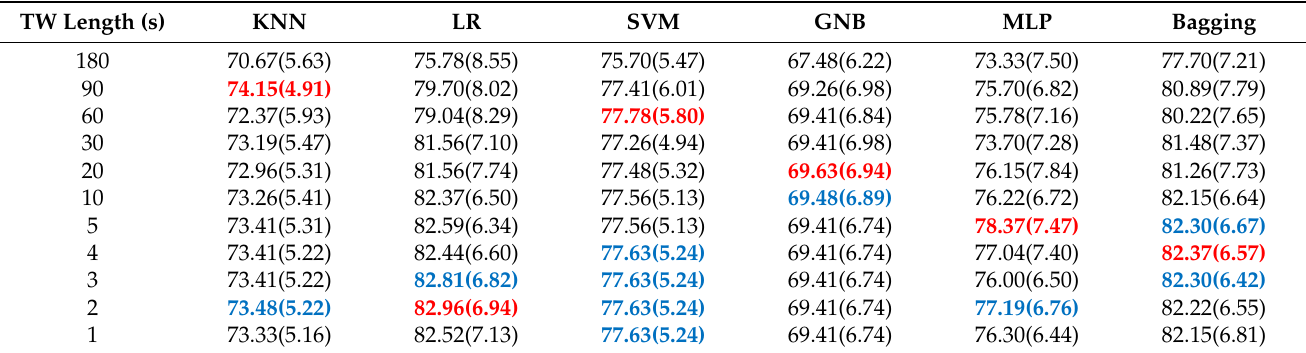
Table 8. The recognition results (mean accuracy and standard deviation) of DE features extracted from separate frequency bands when using different classifiers under different TW lengths with ELBN. The highest and second-highest accuracies of each classifier are highlighted in bold red and bold blue,